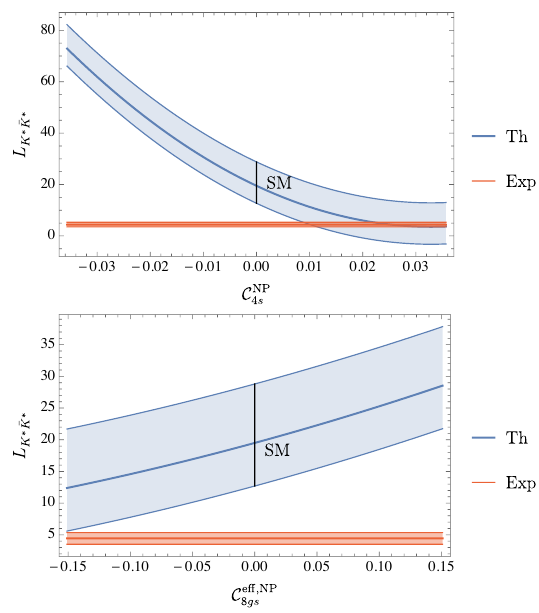
Figure 1 . The tension between the theoretical prediction (blue) and the experimental value (or- ange) is reduced below 1 σ for C NP predictions are given for C NP values. The plots for the remaining Wilson coefficients can be found in appendix C.